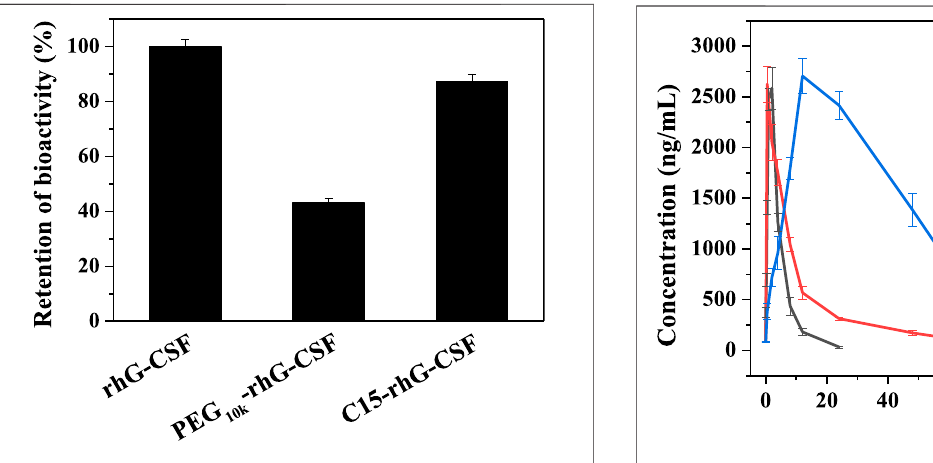
FIGURE 6 | In vitro bioactivities of rhG-CSF, PEG-rhG-CSF and C15- TABLE 1 | Pharmacokinetic parameters of subcutaneous administration of rhG-CSF, PEG 10k -rhG-CSF and C15-rhG-CSF in mice. Parameters a